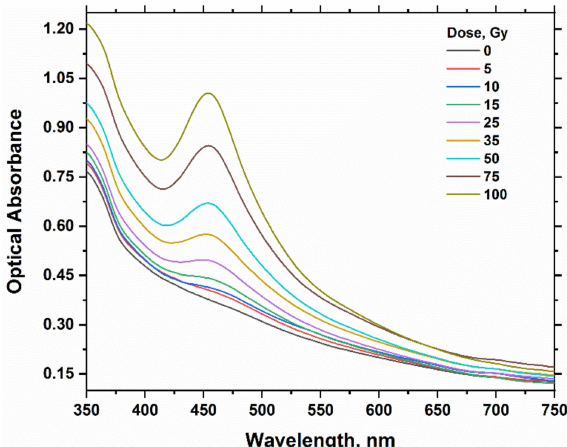
Figure 4. Optical absorption spectra of PAC hydrogel dosimeter (100 mM AgNO 3 and 15% glycerol) unirradiated and irradiated at various absorbed doses values up to 100 Gy.